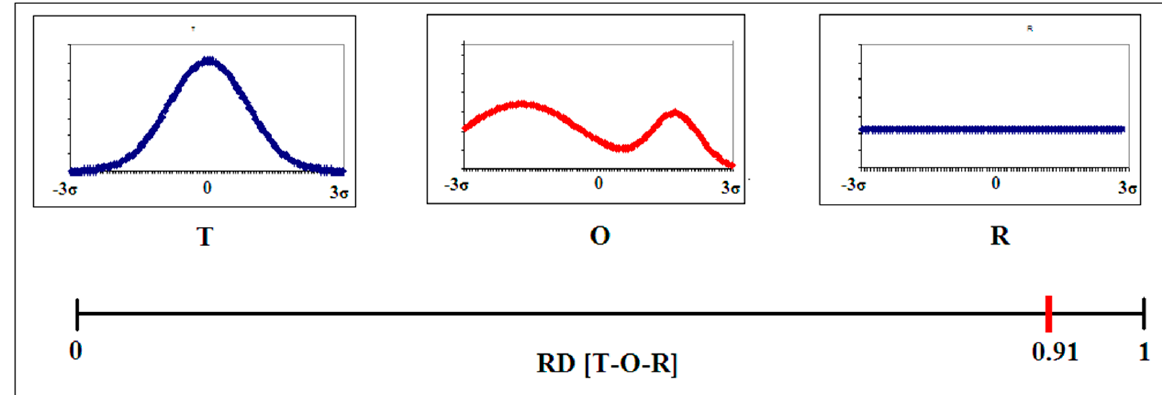
Figure 1. Graphical presentation of determining the value of the RD parameter for the T-O-R relation. The T distribution results from the Gaussian function, the O distribution represents an exemplary observed distribution and the R distribution is a uniform system devoid of variations in the level of hydrophobicity, particularly the central concentration (hydrophobic core). The horizontal axis shows the variability of RD values for the relationship (T-O-R), where the distribution T and R are treated as reference distributions for the observed distribution of O. In the discussed example, this value is 0.91, which means the absence of a hydrophobic core in distribution O. The horizontal axes express spatial coordinates (after normalization it covers the − 3Sigma to +3Sigma range). The molecule is localized with its geometric center in the origin of the coordinate system. This explains the values given on the x -axis. The same is used in all presentations.